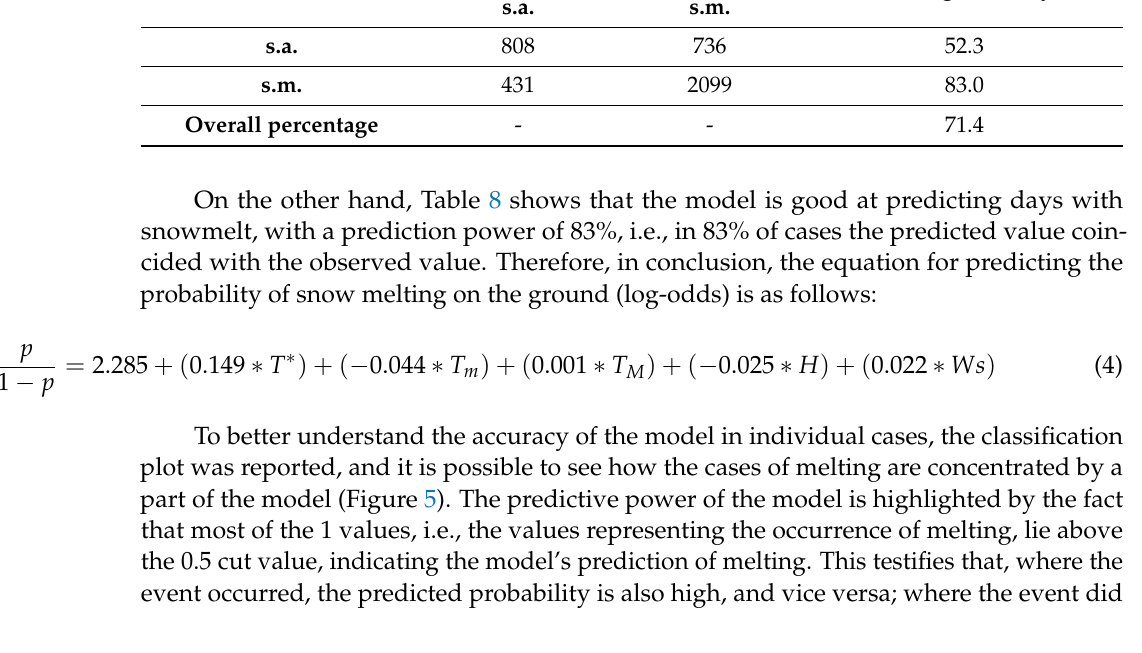
Table 9. Assessment of success in model prediction: snow accumulation ( s.a. ), snow melting ( s.m. ).